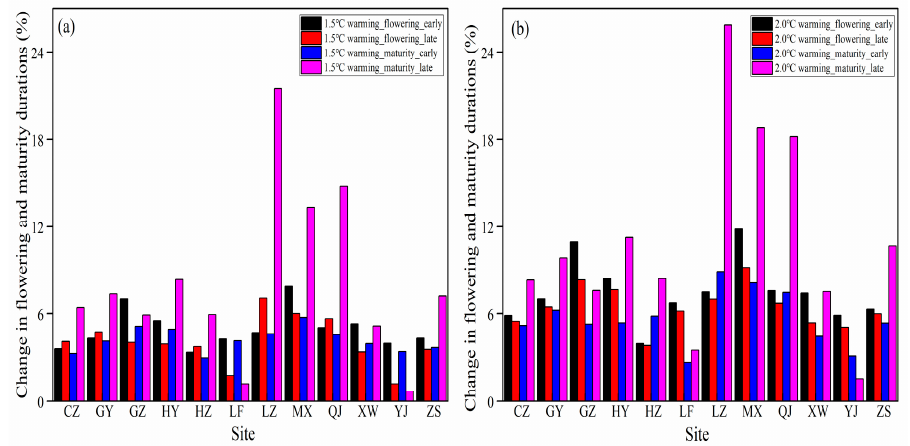
Figure 4. Change in flowering and maturity durations under the 1.5 and 2.0 °C warming scenarios relative to the baseline time, respectively. Note: ( a ) Under the 1.5 °C warming scenario and ( b ) under the 2.0 °C warming scenario.